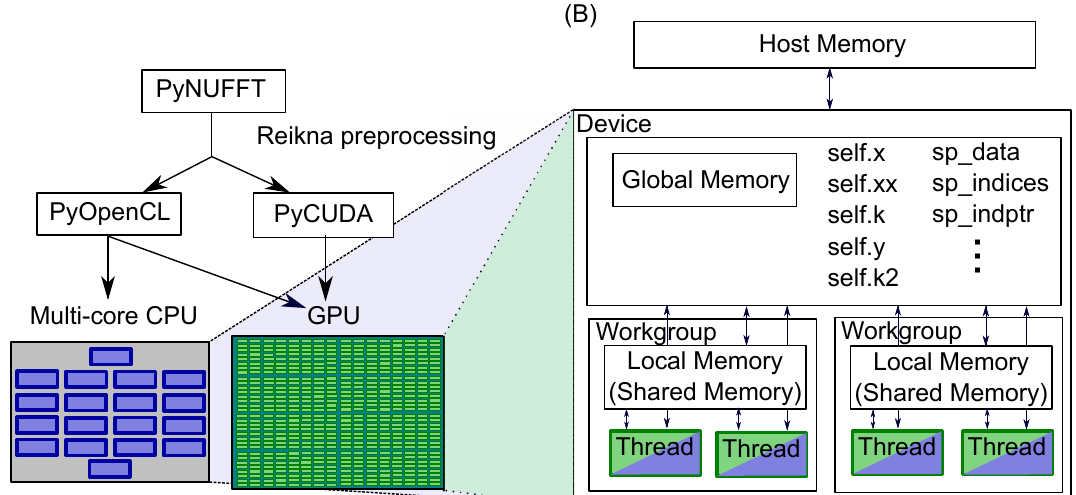
Figure 1. ( A ) The Python non-uniform fast Fourier transform (PyNUFFT) source code is preprocessed and offloaded to the multi-core central processing unit (CPU) or graphic processing unit